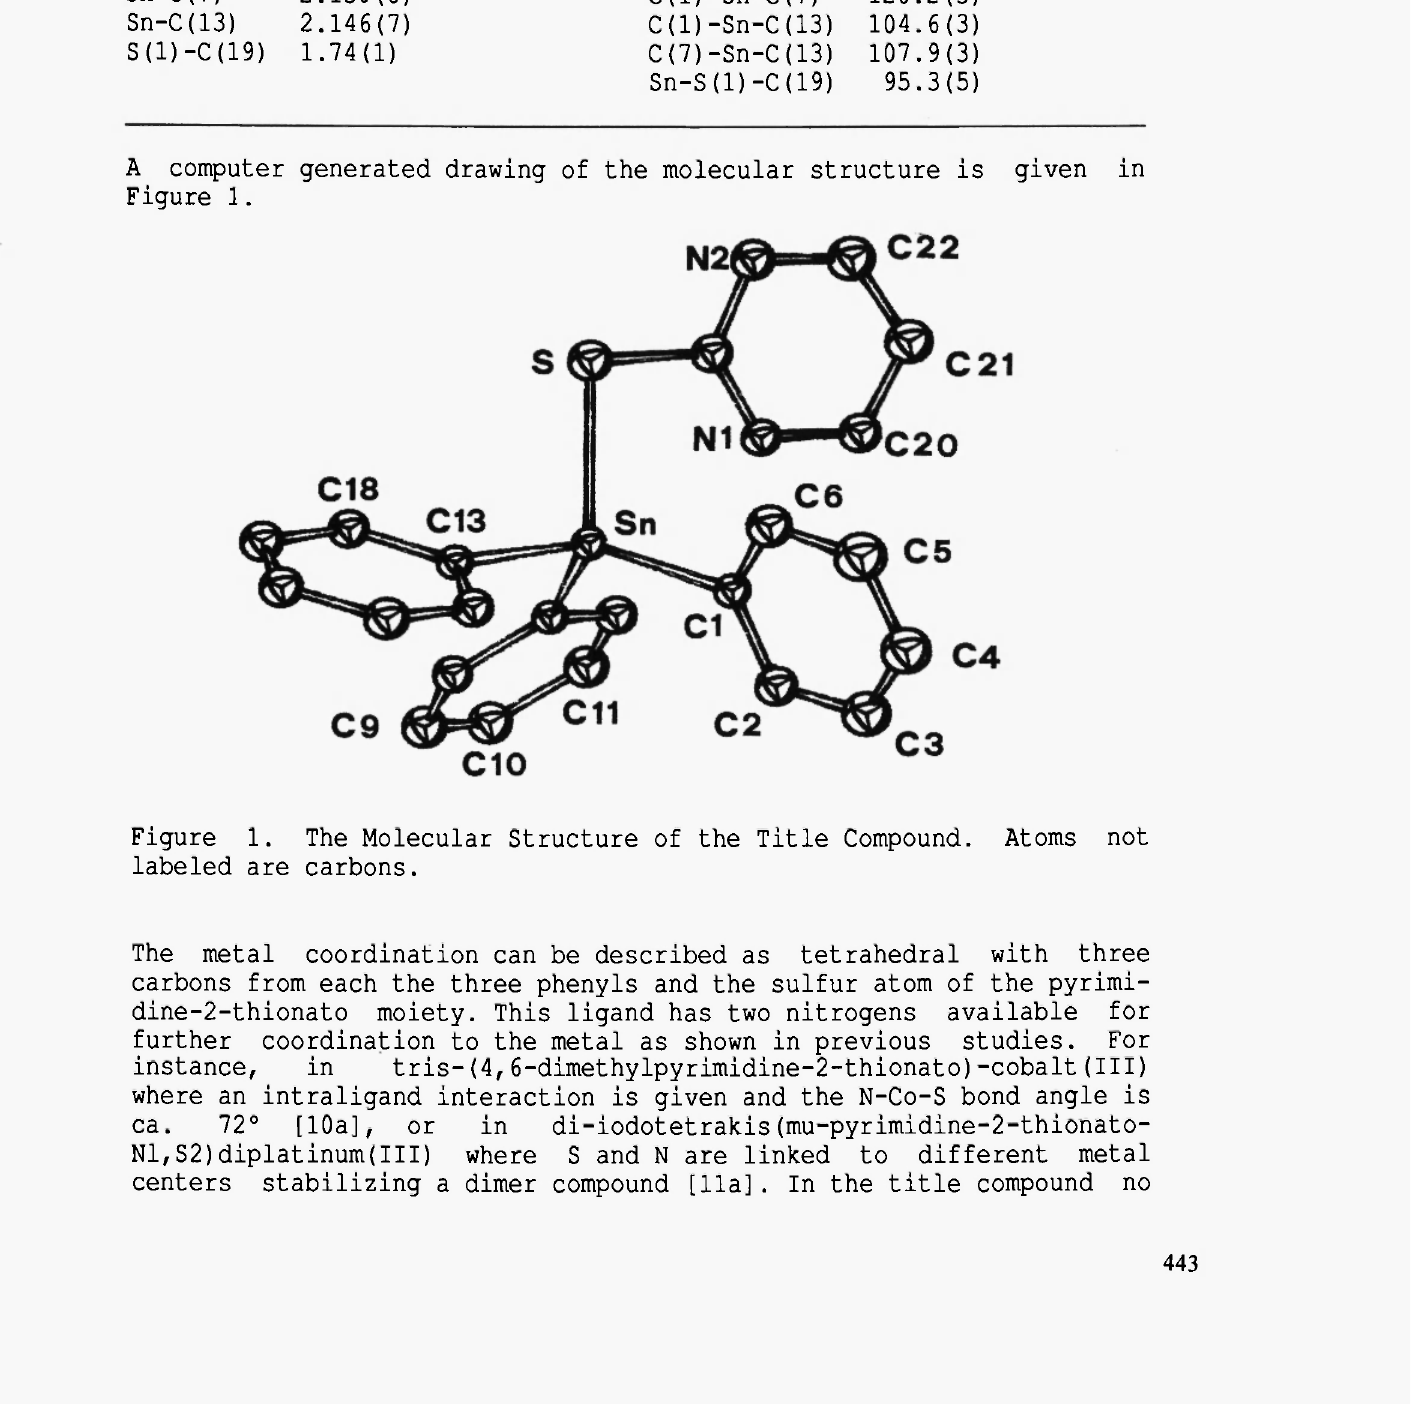
Table 4. Selected Bond Distances and Angles.